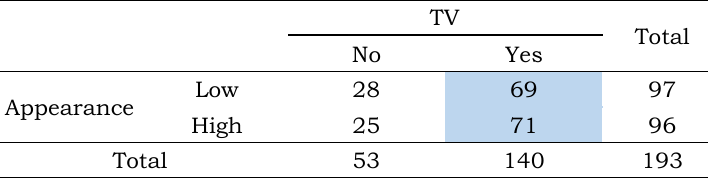
Japanese market, companies sacrificed